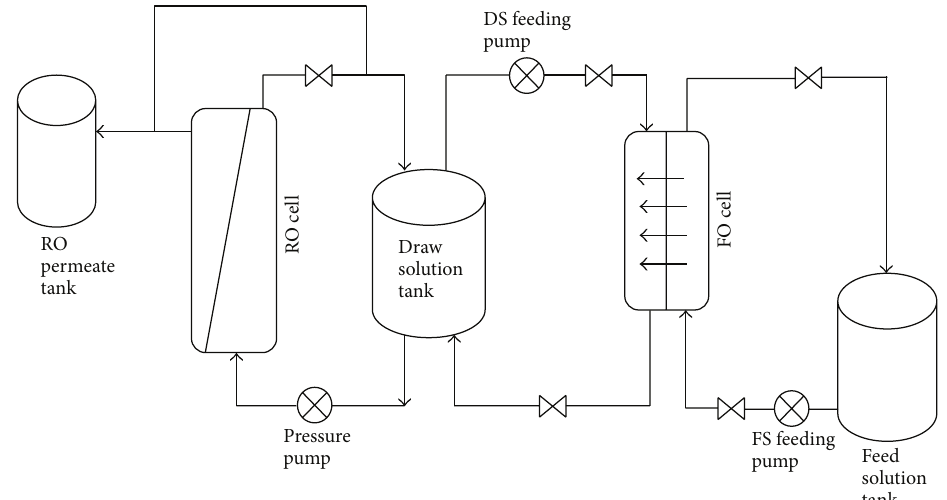
Figure 2: Schematic drawing of the FO/RO experimental setup.